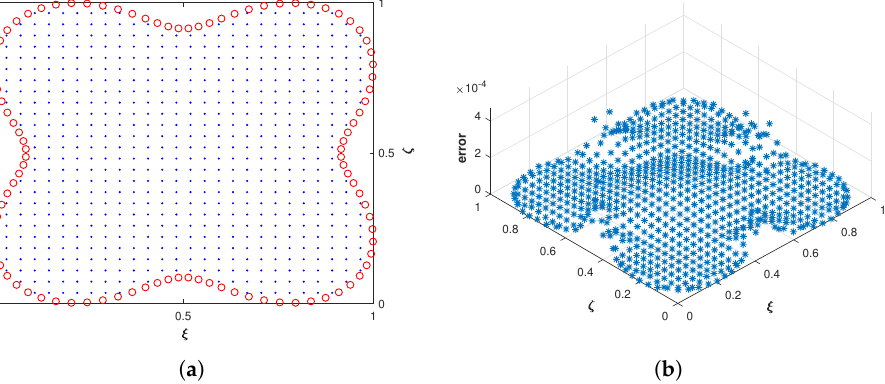
Figure 11. ( a ) Nut Shape domain N = 716. ( b ) absolute error of Problem 3 with N = 716, n = 35, α = 0.65, and M = 26. It can be seen that the proposed numerical scheme has performed well in the nut shape